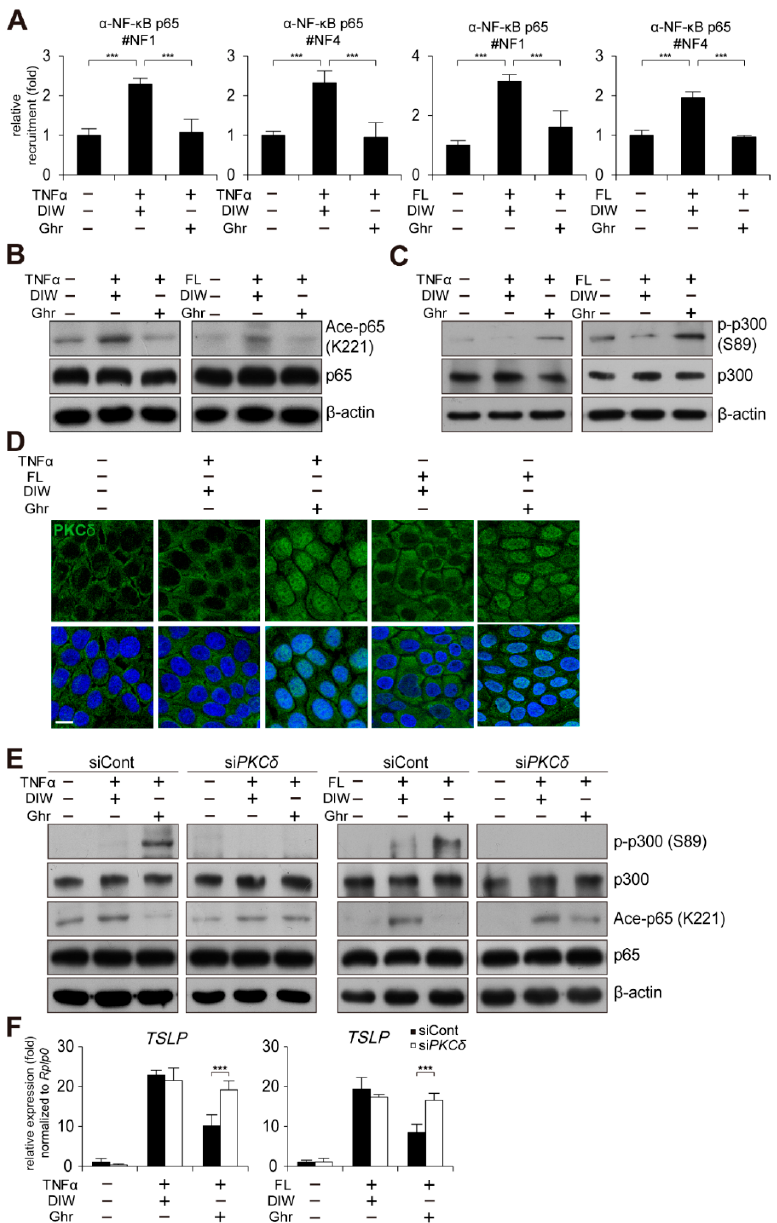
Figure 6. Ghrelin induces PKC δ and p300-mediated reduction of NF- κ B p65 acetylation. ( A ) Ghrelin abolishes the recruitment of NF- κ B p65 to the NF- κ B binding sites on the TSLP gene promoter in HaCaT keratinocytes treated with TNF α or bacterial flagellin (FL). ChIP assay was performed using anti-NF- κ B p65 antibody ( n = 3). Real-time PCR was performed to quantify the occupancy of each protein at the gene promoter encompassing the NF- κ B binding sites (#1 and 4). IgG was used for negative control. DIW was used as solvent for TNF α , flagellin, and ghrelin. ( B ) Ghrelin decreases acetylation of NF- κ B p65 (K221) in HaCaT keratinocytes treated with TNF α or bacterial flagellin. HaCaT keratinocyte lysates were immunoblotted with anti-NF- κ B p65, anti-acetyl NF- κ B p65 (K221), and anti- β -actin antibodies ( n = 3). β -actin was used as a control. Representative images are shown. ( C ) Ghrelin increases phosphorylation of p300 (S89) in HaCaT keratinocytes treated with TNF α or bacterial flagellin. HaCaT keratinocyte lysates were immunoblotted with anti-p300, anti- phospho p300 (S89), and anti- β -actin antibodies ( n = 3). Representative images are shown. ( D )